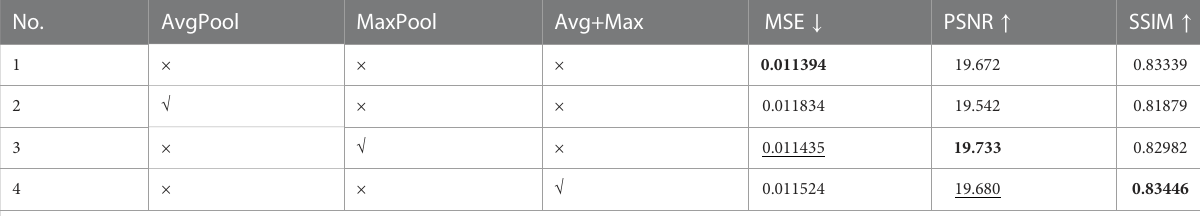
TABLE 4 Experimental results of adding the channel attention module with different pooling methods.